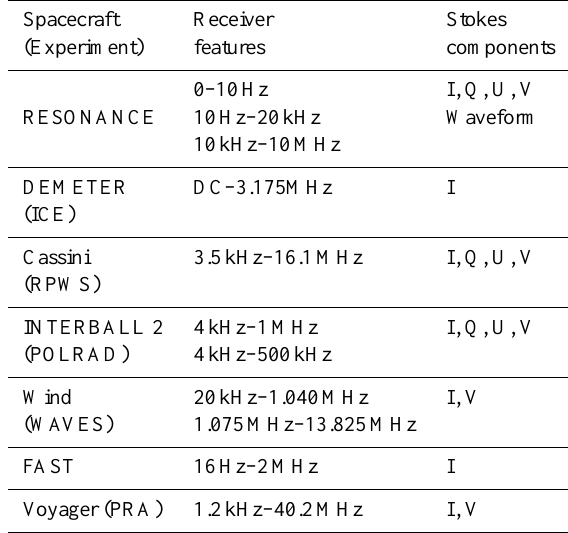
Table 1. Overview of selected science missions and instruments as- sociated with auroral radio emissions